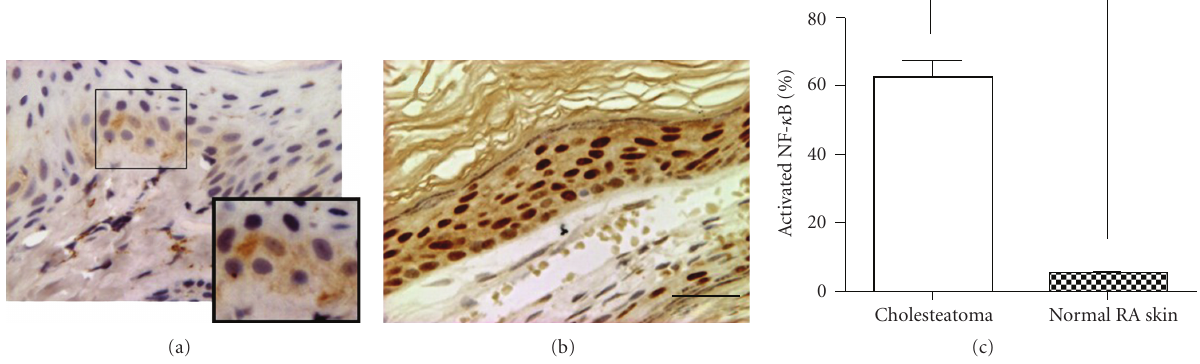
Figure 2: Immunohistochemistry of NF- κ B in cholesteatoma epithelium and normal retroauricular (RA) skin. (a): NF- κ B in normal RA skin. (b): NF- κ B in cholesteatoma epithelium. Note that strong expression was observed in the nuclei of cells in the basal and suprabasal layers of cholesteatoma epithelium, whereas weak NF- κ B immunoreactivity was mainly seen in the cytoplasm of cells in the basal epithelial layers of normal RA skin. Bar = 300 μ m. (c) Rates of positive labeling for NF- κ B in the nuclei of cells in cholesteatoma epithelium and normal RA skin. The rate of cells positive for NF- κ B was significantly higher in cholesteatoma epithelium than in normal RA skin. Data are presented as means ± SD. ∗ P < . 05.